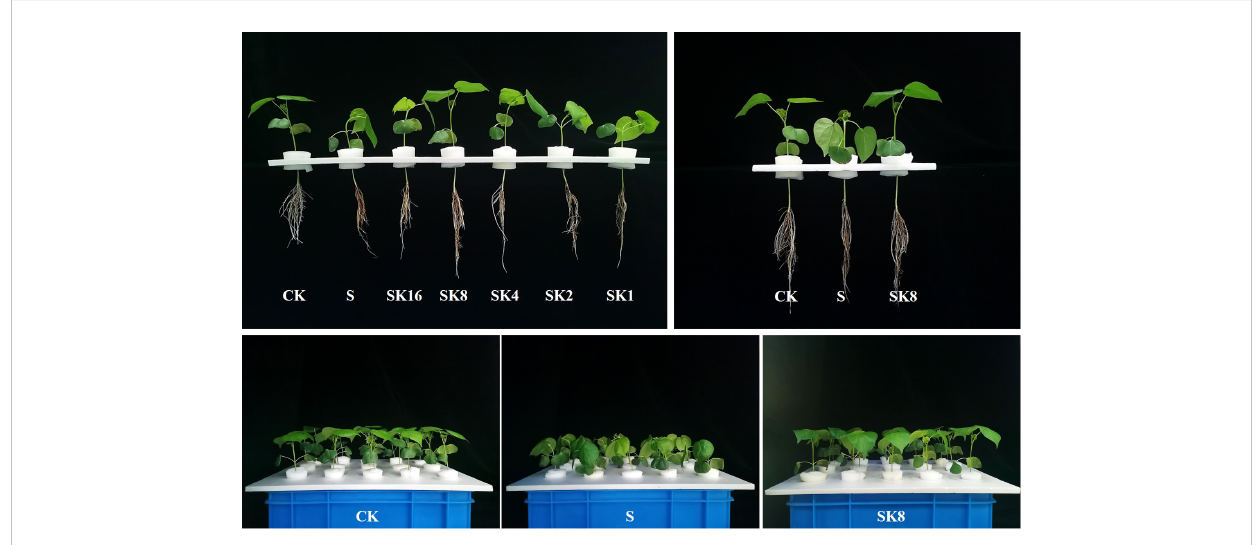
FIGURE 1 Phenotypic difference of cotton under different potassium application